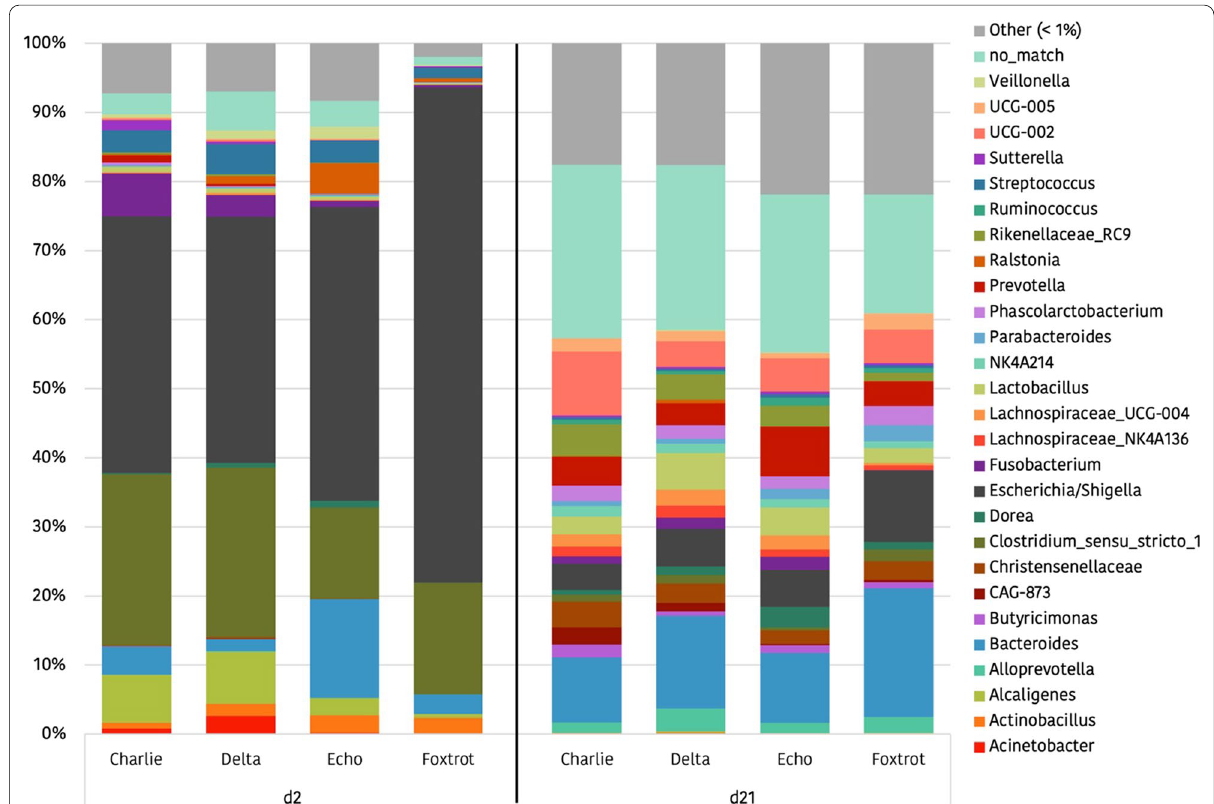
Fig. 6 Bar diagram of the relative abundances (%) of the main genera (> 1%) in Trial 2, organized by farm (Charlie, Delta, Echo or Foxtrot) and by sampling day. In Echo and Foxtrot farms the sows received medicated